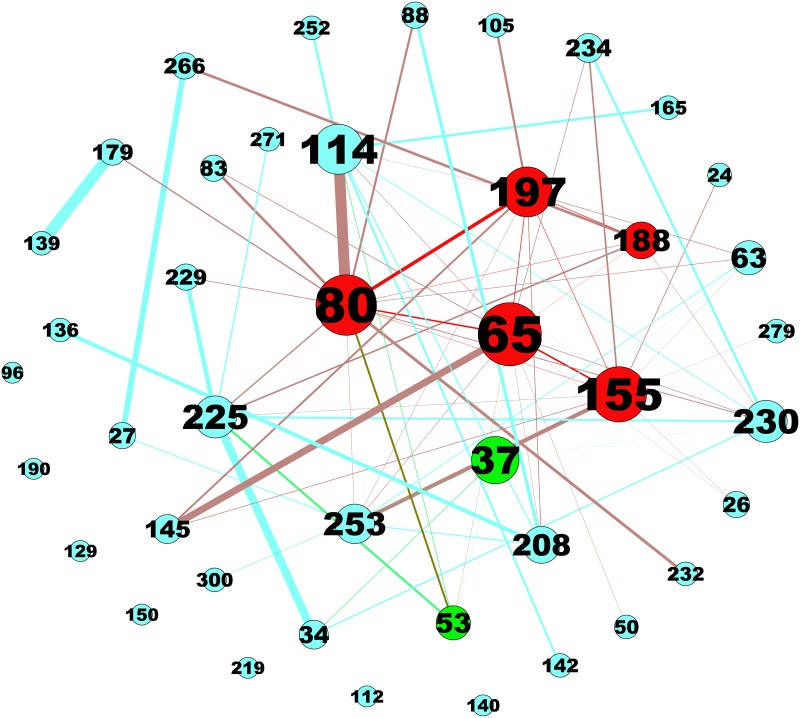
Interactions between 42 topological modules.Red nodes: seed genes of modules > = 10; blue nodes: seed genes of modules < 10; green nodes: extensional modules. Node size corresponds to degree of module. The thickness of the edge is proportional to the weight, and the weight corresponds to strength of interactions.